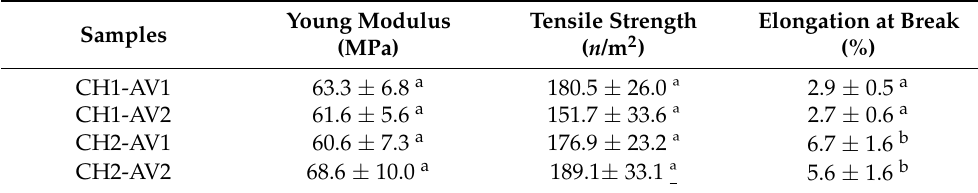
Table 3. Effect of the concentrations of chitosan and aloe vera extract on Young modulus, tensile strength, and elongation at the breaking point for the emulsified films. Young Modulus Tensile Strength Elongation at Break Samples (MPa) ( n /m 2 ) (%) CH1-AV1 63.3 ± 6.8 a 180.5 ± 26.0